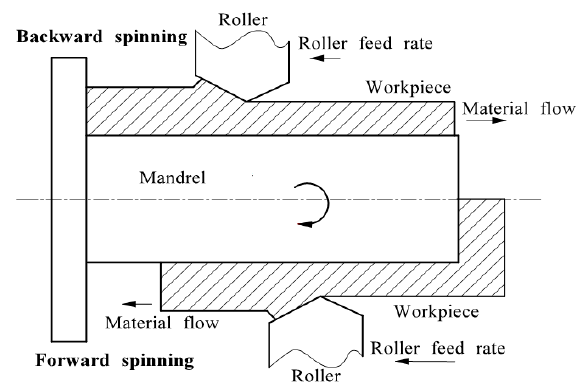
Figure 1. Schematic of forward and backward tube spinning.